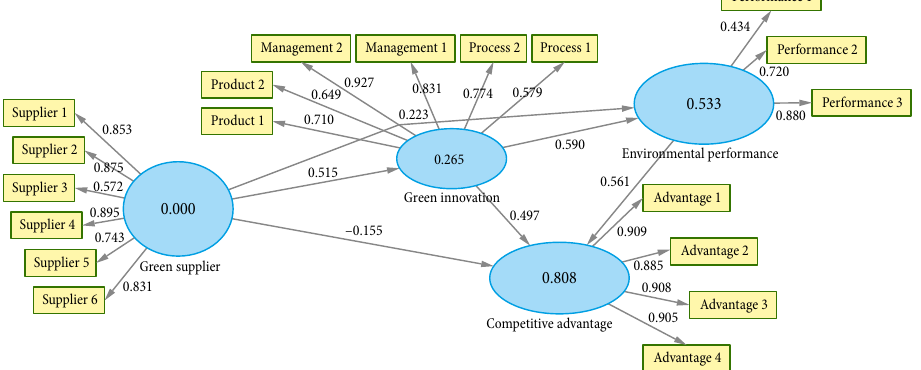
Fig. 3. Determination of the coefficient R 2 and path coefficients between the independent and dependent